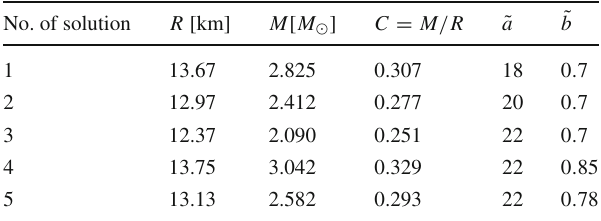
Table 4 Properties of five interior solutions assuming a negative G (cid:5) ( r = 0